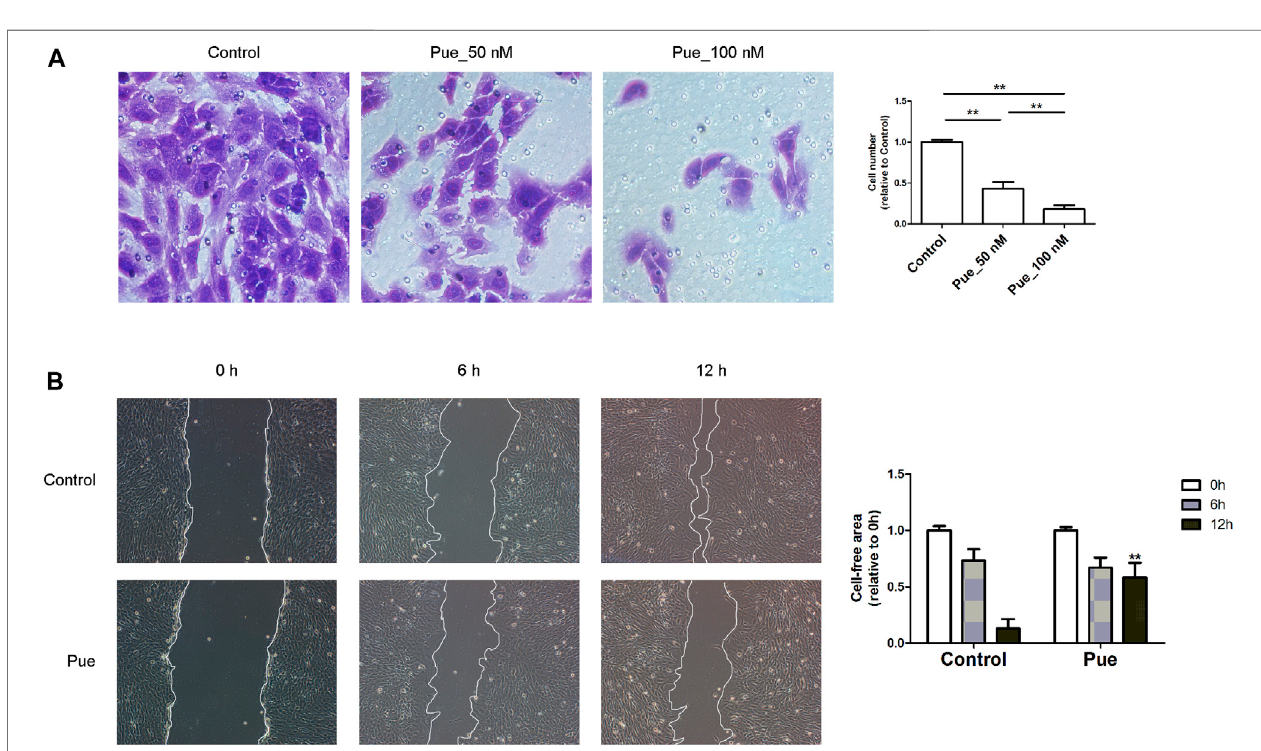
FIGURE 5 | Puerarin inhibited the migration of HPSCs. (A) Transwell cell migration assay result in HPSCs. Images showing cells that migrating through the transparentpolyethyleneterephthalate membranewerecaptured aftertreatmentwithorwithoutpuerarin(50, 100 nM)for24 h. Theaveragecellnumbersofsixrandom areas of each group were calculated and presented in the bar chart. * p < 0.05, ** p < 0.01. (B) Wound-healing assay result in HPSCs treated with or without puerarin (100 nM),imageswerecapturedat0,6and12 hafterscratching.Cell-freeareawasquanti fi edusingImageJandstatisticallypresentedinthehistogram.* p < 0.05, ** p < 0.01 vs.